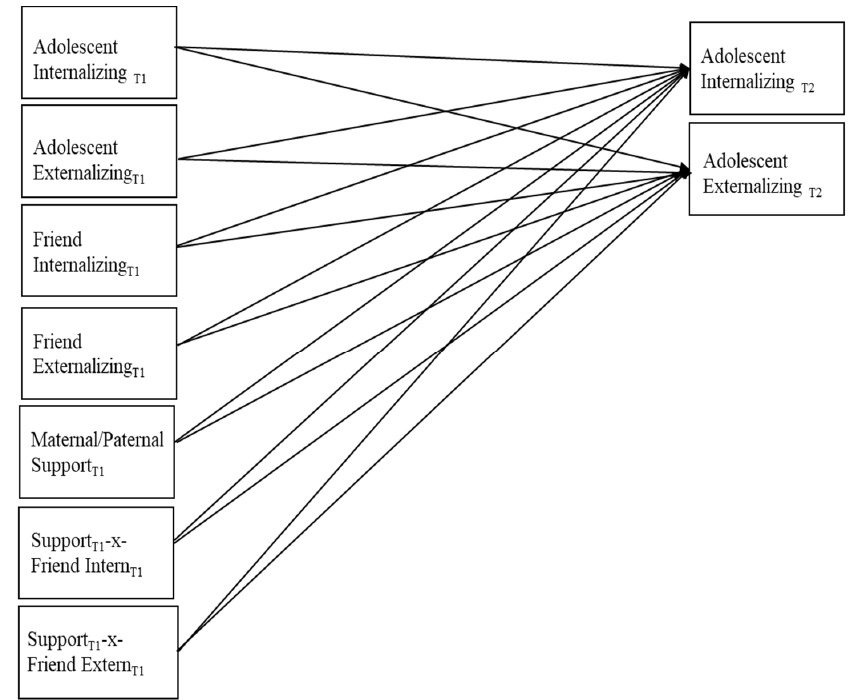
Figure 1. Hypothesized path model. Within-time covariances are not displayed for ease of communication.